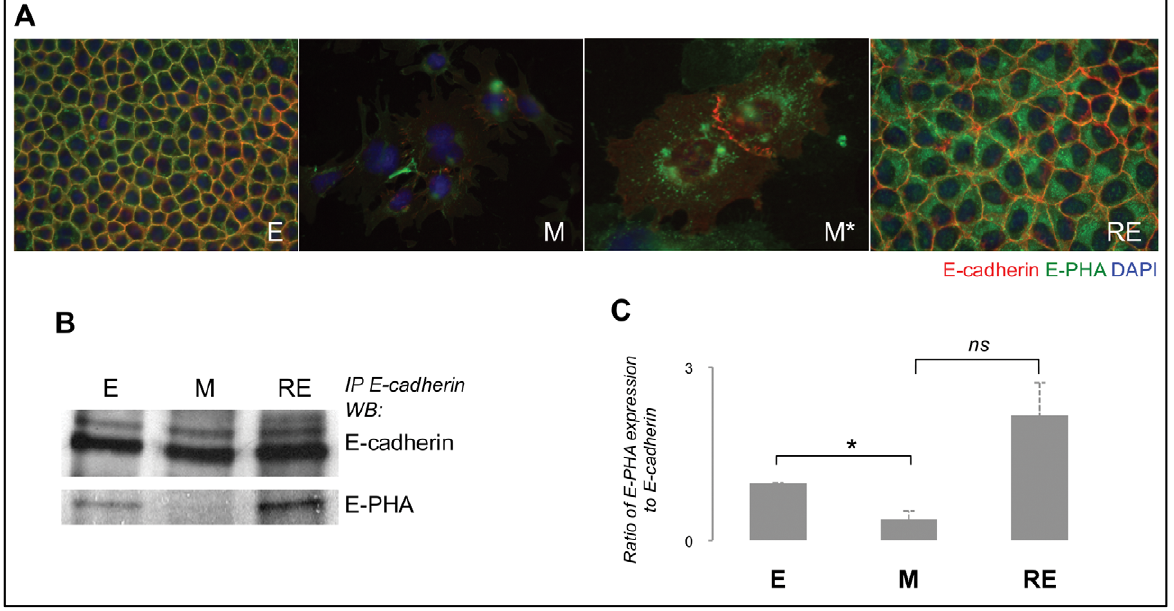
Figure 5. GnT-III-mediated E-cadherin glycosylation during EMT/MET. Panel A shows the co-immunofluorescence for E-cadherin and E-PHA (400 6 for E, M, RE and 630 6 for M*) illustrating that E-cadherin and bisecting GlcNAc structures co-localize in the cell membrane in E and RE. In mesenchymal cells (M and M*), it was observed a significant decrease in both the expression of E-cadherin and bisecting GlcNAc structures. M cells shows residual E-cadherin expression at the focal points of intercellular contacts (red, E-cadherin) and some green staining (E-PHA reactivity) could be observed in the perinuclear region (Golgi compartment). Immunoprecipitation of E-cadherin followed by E-PHA lectin blot is represented in panel B. Panel C represents the normalization of bisecting GlcNAc structures (E-PHA reactivity) that are modifying E-cadherin. Amounts of N-glycan structures were determined from the ratios of densities of E-PHA reactivity after normalization to E-cadherin. Results are described as mean 6 standard error mean of two biological replicas. Single asterisk corresponds to p # 0.05 and ns stands for non-significant, p . 0.05. The modification of E-cadherin with bisecting GlcNAc N-glycan structures in E, M and RE are expressed as the fold increase, compared with the E cells. Panels B and C show that E- cadherin is specifically glycosylated with bisecting GlcNAc structures in E, losing this glycoform in M and recovering again in